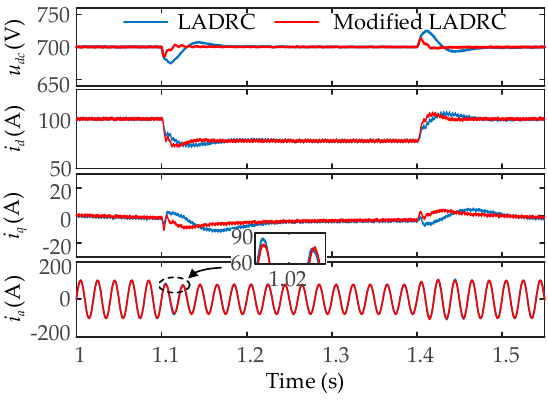
Figure 14. Robustness comparison under solar radiation variations.